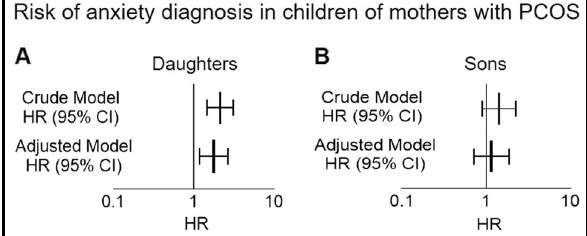
Fig. 1 Risk of having an anxiety in daughters of women with PCOS. A , B Crude and adjusted hazard ratios (HRs) and 95% con fi dence intervals (CIs) for the association between maternal PCOS and daughter ’ s diagnosis of anxiety in the Swedish nation-wide register-based study. Adjusted model is adjusted for maternal age, maternal country of birth, maternal education, maternal and paternal psychiatric history, and year of birth of